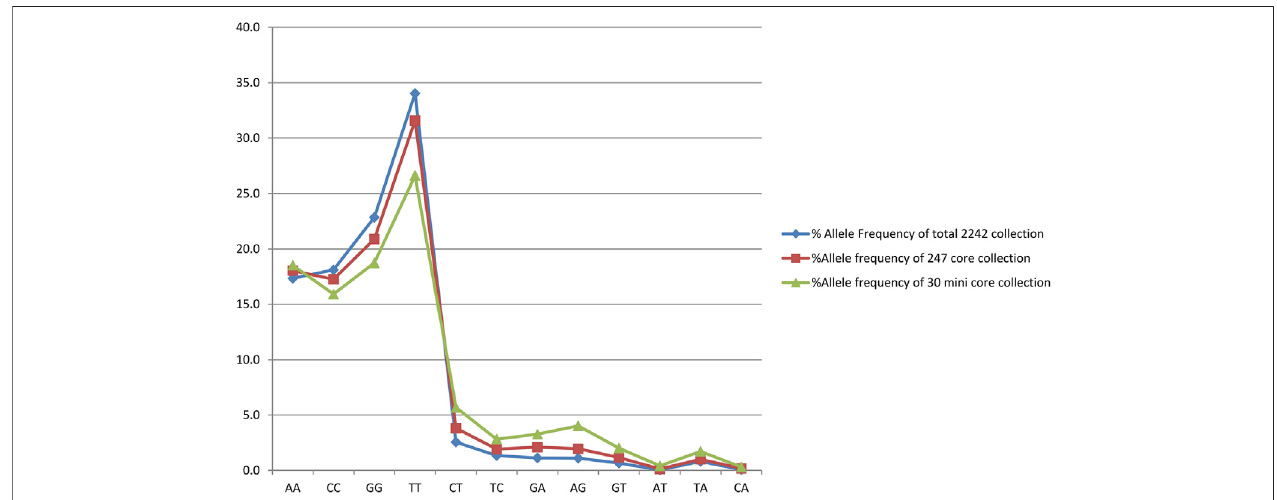
FIGURE 3 | Graph showing the allele frequency of total east coast collection, core collection, and mini core collection.